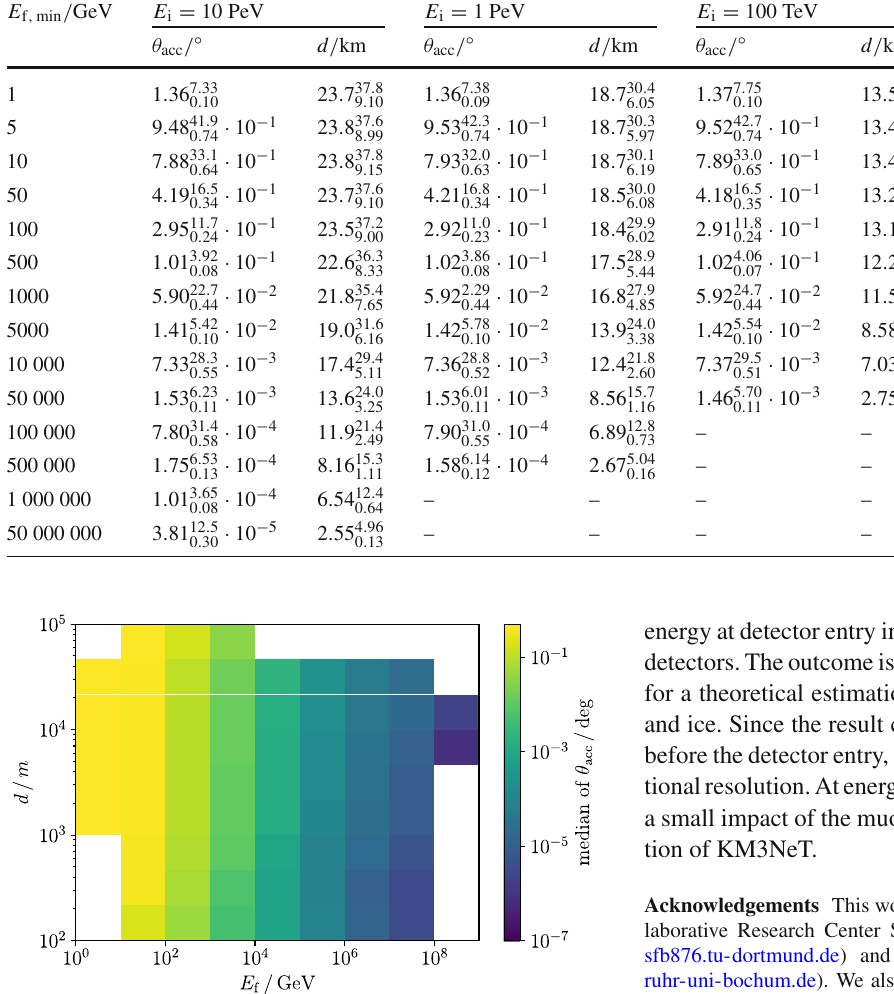
Table 3 The median values for the accumulated deflection θ acc in degree and the propagated distances d in meter are presented for Fig. 5. The upper and lower values indicate the upper und lower 99% inter-